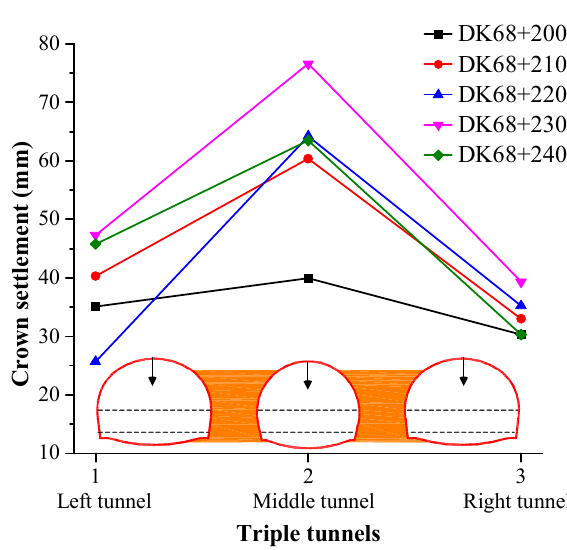
Figure 8. Crown settlements of triple tunnels in the experimental section.